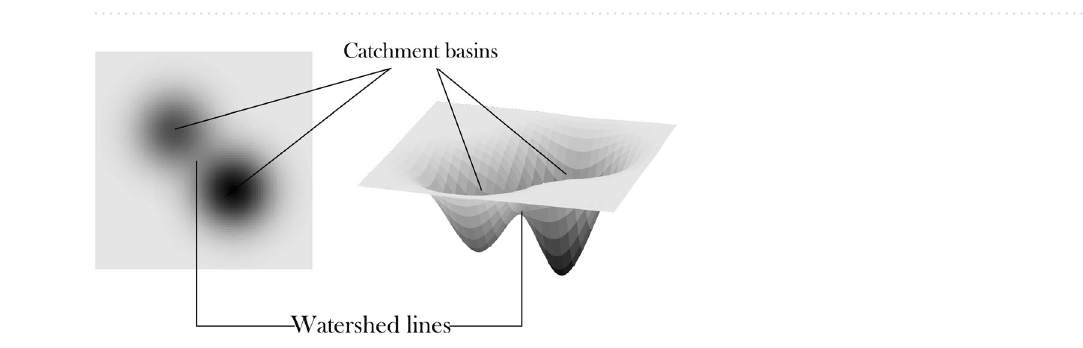
Figure 5. PathoNet architecture.